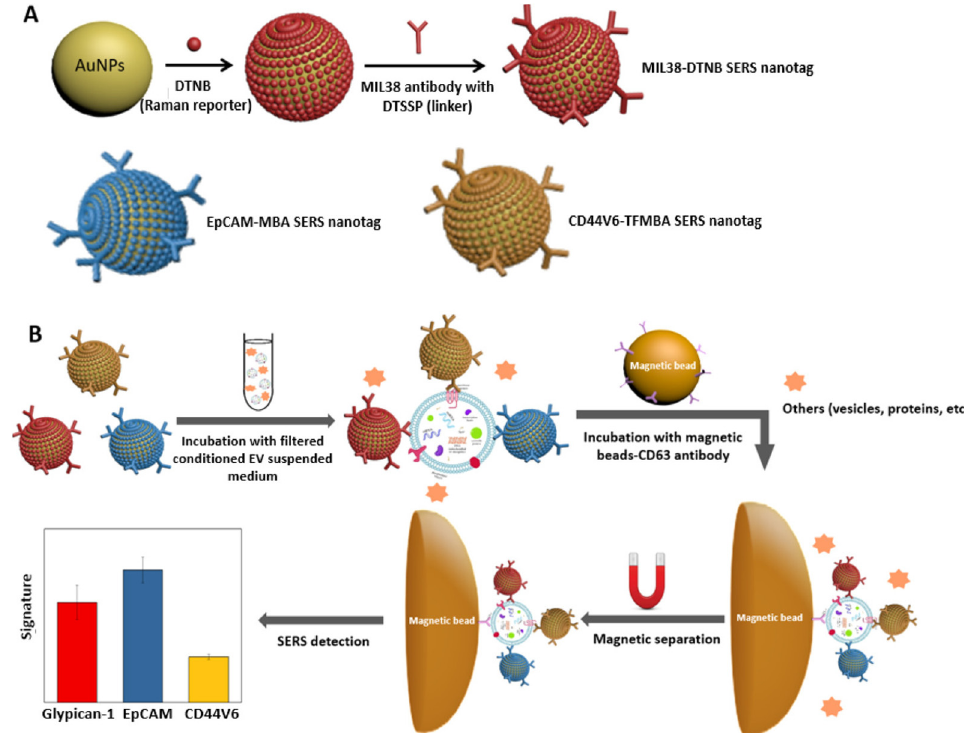
Figure 4. SERS-based sandwich immunoassay for the phenotypic profiling of cancer-derived small extracellular vesicles. ( A ) Nanotag preparation. ( B ) SERS nanotags and magnetic beads used for the molecular phenotype profiling of CD63-positive extracellular vesicles (EVs). Reproduced with permission from [46]. Copyright 2020, American Chemical Society.